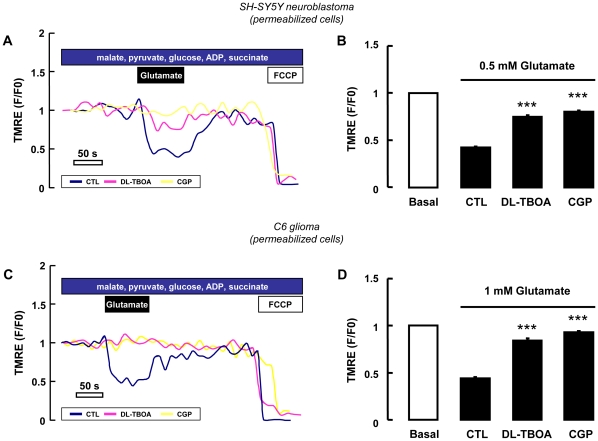
Real-time membrane potential analysis in permeabilized cells.Experiments performed in digitonin-permeabilized SH-SY5Y (A,B) and C6 (C,D) cells using TMRE at non-quencing concentration (10 nM). Glutamate perfusion induced a mitochondrial depolarization (blue line). Both DL-TBOA (300 µM) and CGP-37157 (3 µM) prevented the glutamate-stimulated mitochondrial depolarization (pink and yellow lines, respectively). FCCP (5 µM) was added at the end as an internal control in each experiment. Mitochondria response was analyzed as the ratio of fluorescence during maximal glutamate depolarization versus pre stimulus levels. Each bar represents the mean ± SEM of 50–100 cells recorded in 5 different sessions (B,D). *** p<0.001 vs control.